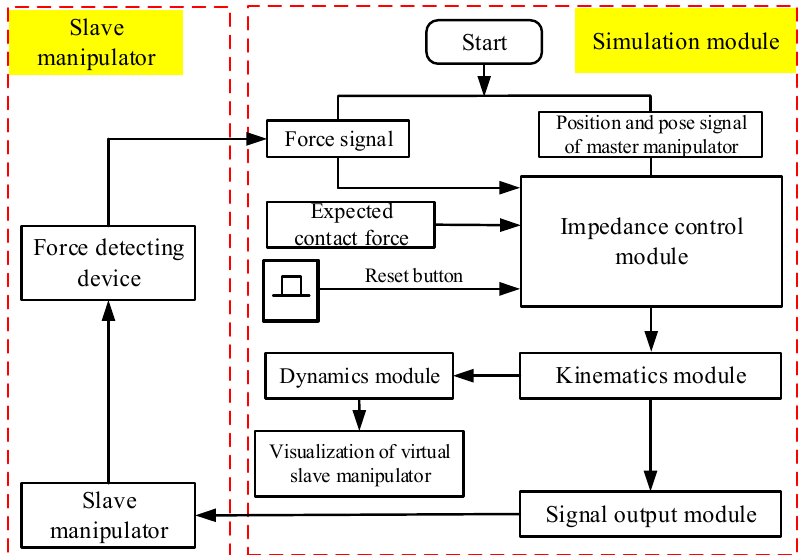
Figure 14. Block diagram of the working principle of the control system model.